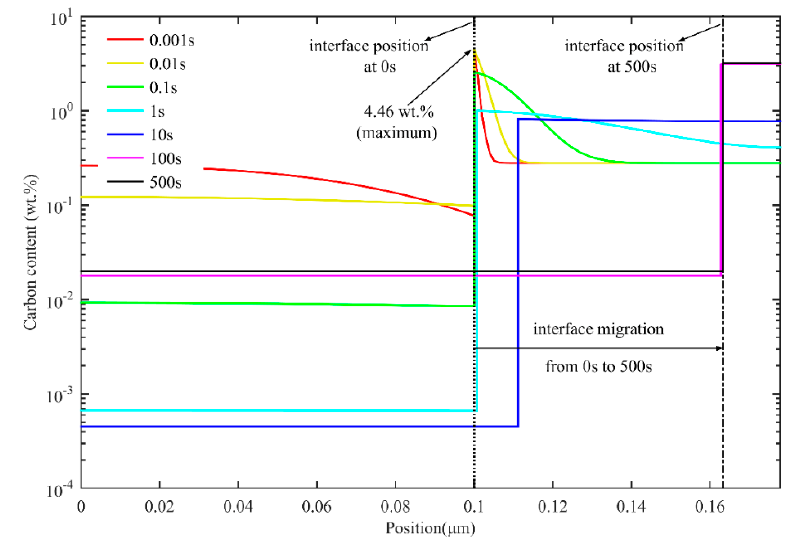
Figure 3. Simulation of carbon redistribution during partitioning at 425 ◦ C for 500 s after quenching to 300 ◦ C (one-stage Q-P process).